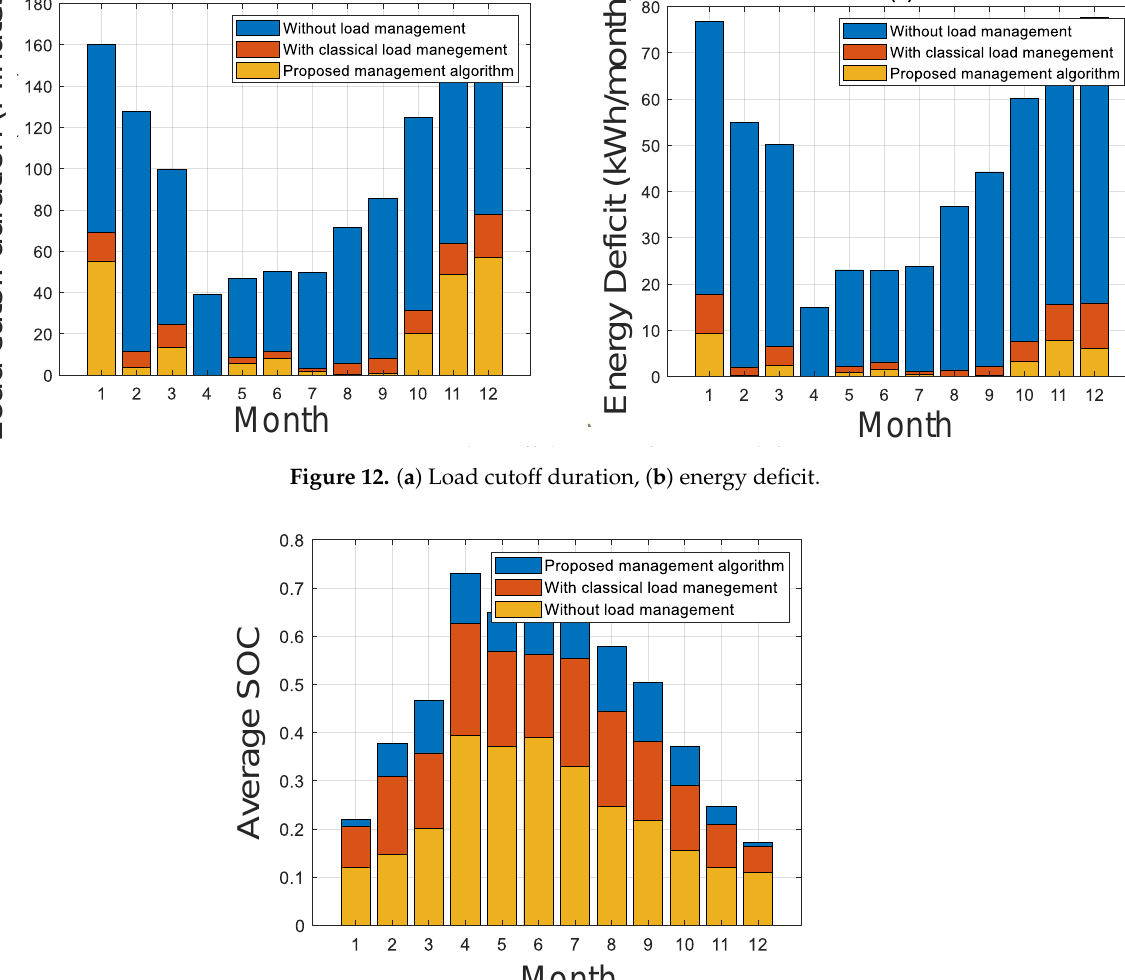
Figure 13. Battery SOC.